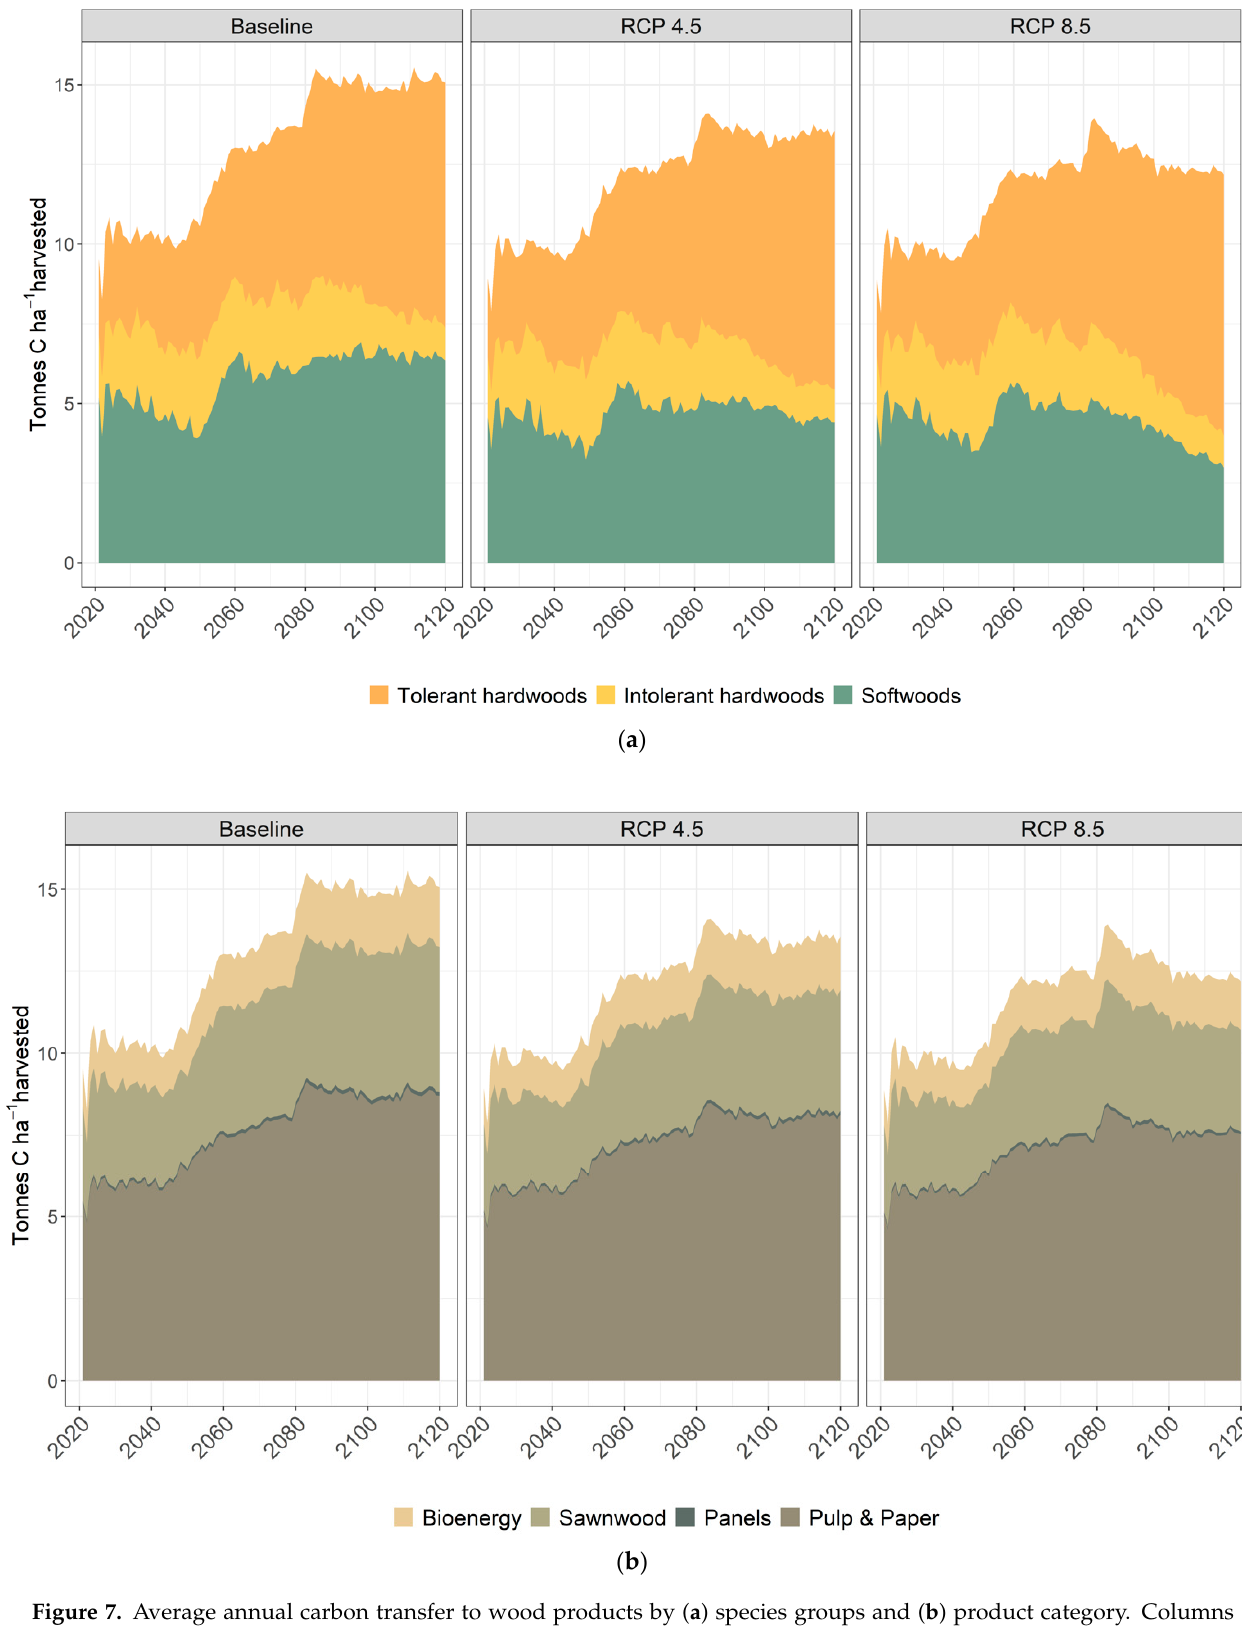
Figure 7. Average annual carbon transfer to wood products by ( a ) species groups and ( b ) product category. Columns correspond to climate scenarios, and rows to management scenarios, i.e., conservation, and ecosystem-based forest management. See Table 1 for list of species. Results are based on the average of five replicates.